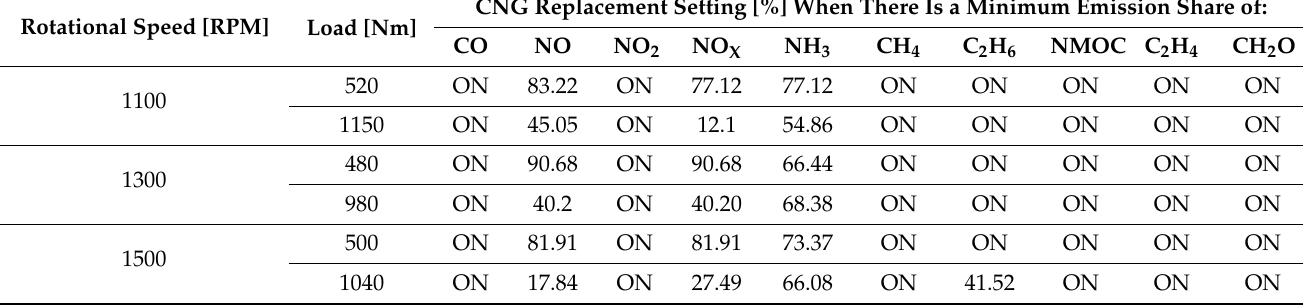
Table 3. The replacement of diesel/CNG setting with the lowest emission of harmful